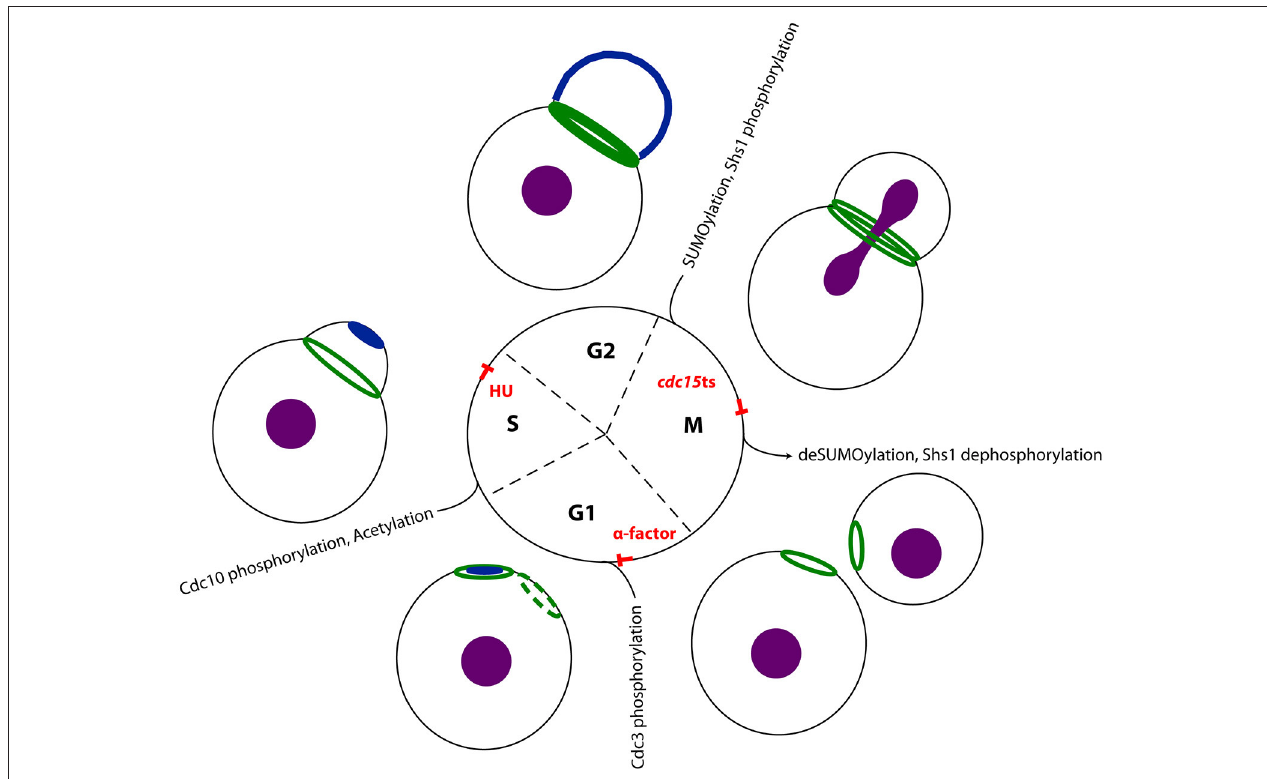
FIGURE 2 | Septins in the cell cycle of S. cerevisiae . The septins undergo cell cycle depending transitions: In G1 phase active Cdc42 (dark blue) polarizes at the plasma membrane, defining the presumptive bud site. The septins (dark green) are recruited to this site and remain as a ring at the neck upon bud emergence. This ring expands into a stable hourglass-shaped collar until the onset of mitosis. In late anaphase the septin collar splits into two distinct rings. In a recent study, Renz et al. detected interaction partners systematically at different stages of the cell cycle and could thereby reconstitute a time-resolved interactome of the septin rod ( Renz et al., 2016). Treatment of the yeast cells with alpha factor arrested cells in early G1 phase, where no septin structure was visible. Using hydroxyurea arrested the cells in S-phase, where a stable septin ring was visible at the bud neck. Finally, a temperature shift in cells carrying a cdc15-1 allele, allowed determining interaction partners with split septin rings. The respective cell cylce blocks and major known post translational modifications ( Hernández-Rodríguez and Momany, 2012) of the respecive cell cycle state are indicated. The nucleus is colored in